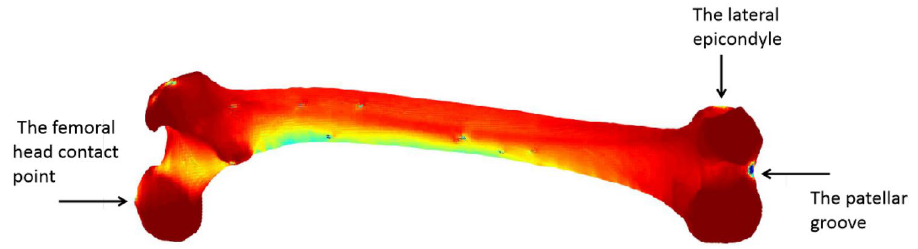
Figure 4. 3-dimensional model for femur and the boundary condition